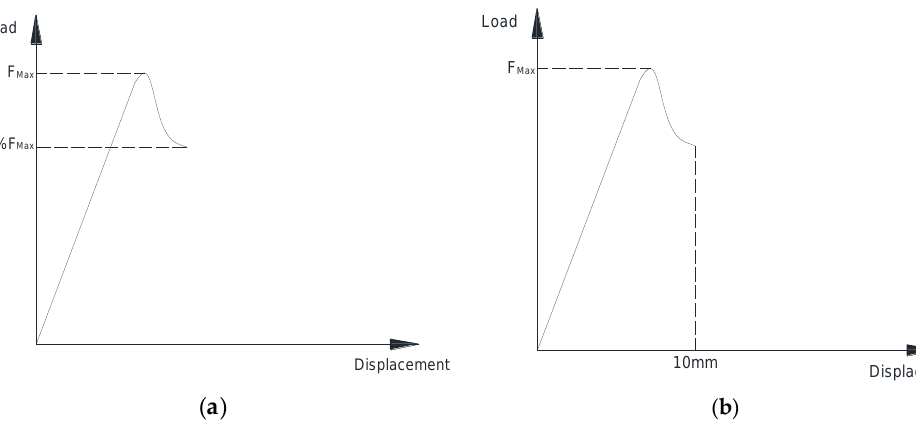
Figure 4. Termination rule of the flexural test. ( a ) Drop to 30% of the maximum load; ( b ) Maximum displacement of 10 mm.